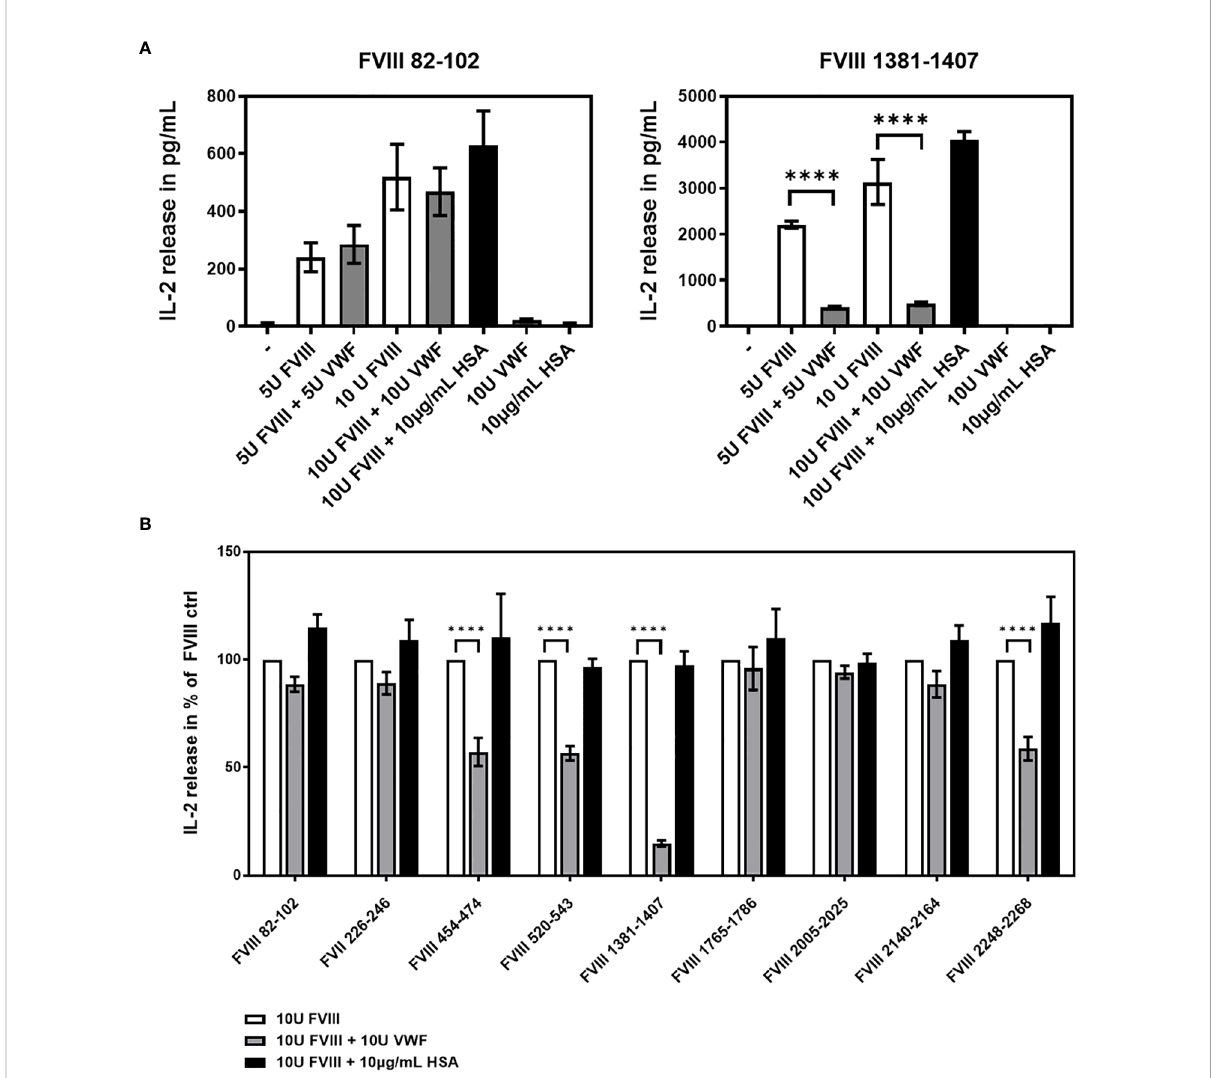
FIGURE 3 VWF present during preincubation of APCs modulates presentation of FVIII-derived peptides and subsequent stimulation of peptide-speci fi c CD4+ T cells hybridoma clones. FVIII speci fi c CD4+ T cell hybridoma clones were cocultured with APCs preincubated with either human FVIII only or a complex of human FVIII with human VWF. As a control, FVIII was mixed with Human Serum Albumin in the same protein concentration as used for VWF. After 48 hours culture of preincubated APCs with CD4+ T cell hybridoma clones, culture supernatants were collected and analyzed for IL-2 release as an indicator for the activation of the CD4+ T cell hybridoma clones. (A) Two representative examples for the in fl uence of VWF present during the preincubation of APCs on the subsequent activation of FVIII-speci fi c CD4+ T cell hybridoma clones speci fi c for different FVIII peptide regions. Presented is the mean value ± SD (B) Overview of the in fl uence of VWF present during the preincubation of APCs on the subsequent activation of FVIII-speci fi c CD4+ T cell hybridoma clones speci fi c for the different FVIII peptide regions tested. Depicted is the mean value ± SEM. Results were derived from 6 independent experiments, each done in triplicates (n=18). Statistical analysis for signi fi cance between different groups of measured mean IL-2 release was assessed by a two-way ANOVA with Sidaks ’ s multiple comparison test using Graphpad Prism 9 (GraphPad Software, Inc., California USA). P < 0.05 was considered statistically signi fi cant. *p<0.05; **p<0.01; ***p<0.001; ****p<0.0001. Detailed data including statistical analysis are depicted in Table